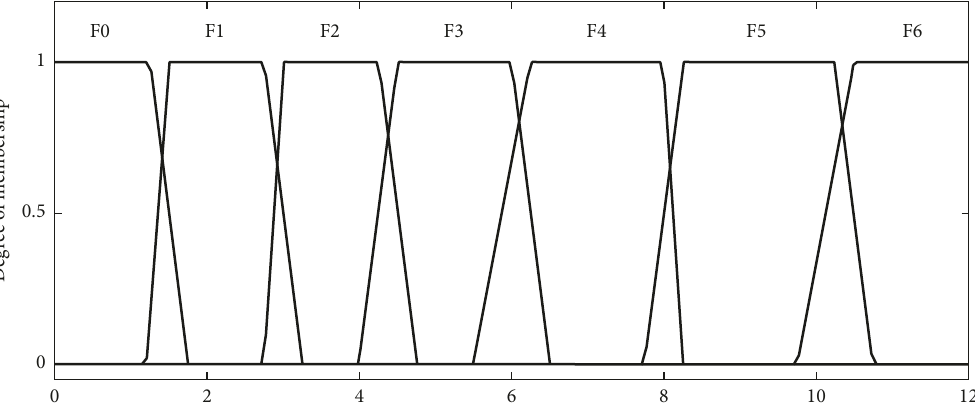
Figure 7: Output variable MF-fault type.